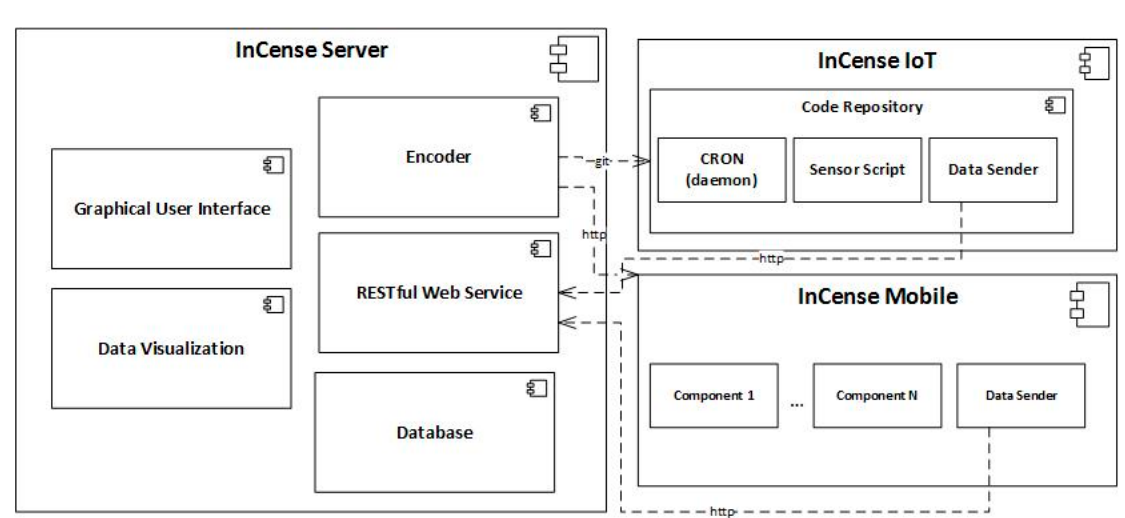
Figure 3. GUI for data visualization.